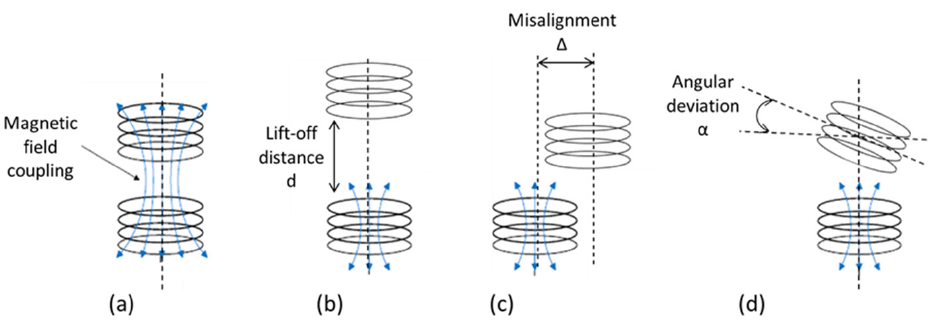
Figure 5. Possible coils positions: ( a ) ideal case; ( b ) big lift-off distance; ( c ) lateral misalignment; and ( d ) angular misalignment.